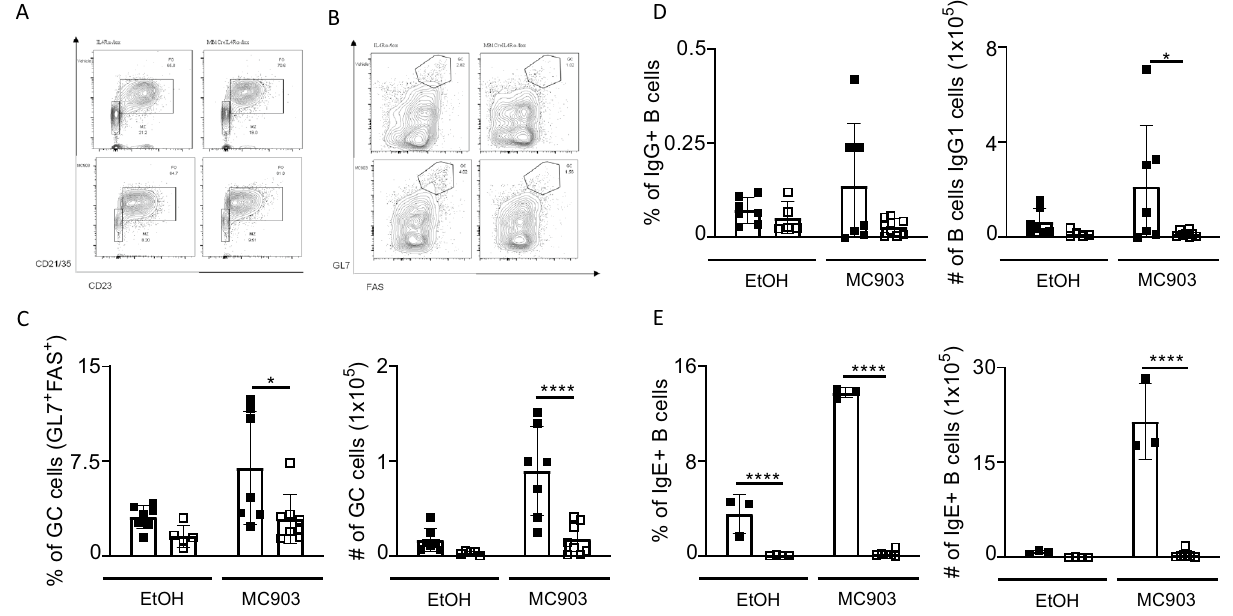
Figure 6. IL-4R ⍺ responsiveness in B cells essential in GC and class switching during acute MC903-induced atopic dermatitis. (A) Representative FACS plots of Follicular (FO) and marginal zone (MZ) B cells in inguinal lymph nodes between IL-4R ⍺ −/lox and mb1 cre IL-4R ⍺ −/lox treated with EtOH and MC903. ( B ) Representative FACS plots of Germinal Centre (GCs) B cells in inguinal lymph nodes. ( C ) Frequency and the total number of GC B cells. ( D ) Frequency and the total number of IgG1 + B cells. ( E ) Frequency and the total number of IgE + B cells. Shown are 2 pooled experiments with mean ± SEM. Statistical analysis was performed using Student t-test Mann–Whitney where *p < 0,05, **p < 0,01 between littermate IL-4Rα –/lox EtOH group vs MC903 treated mice. n = 5–8 mice per